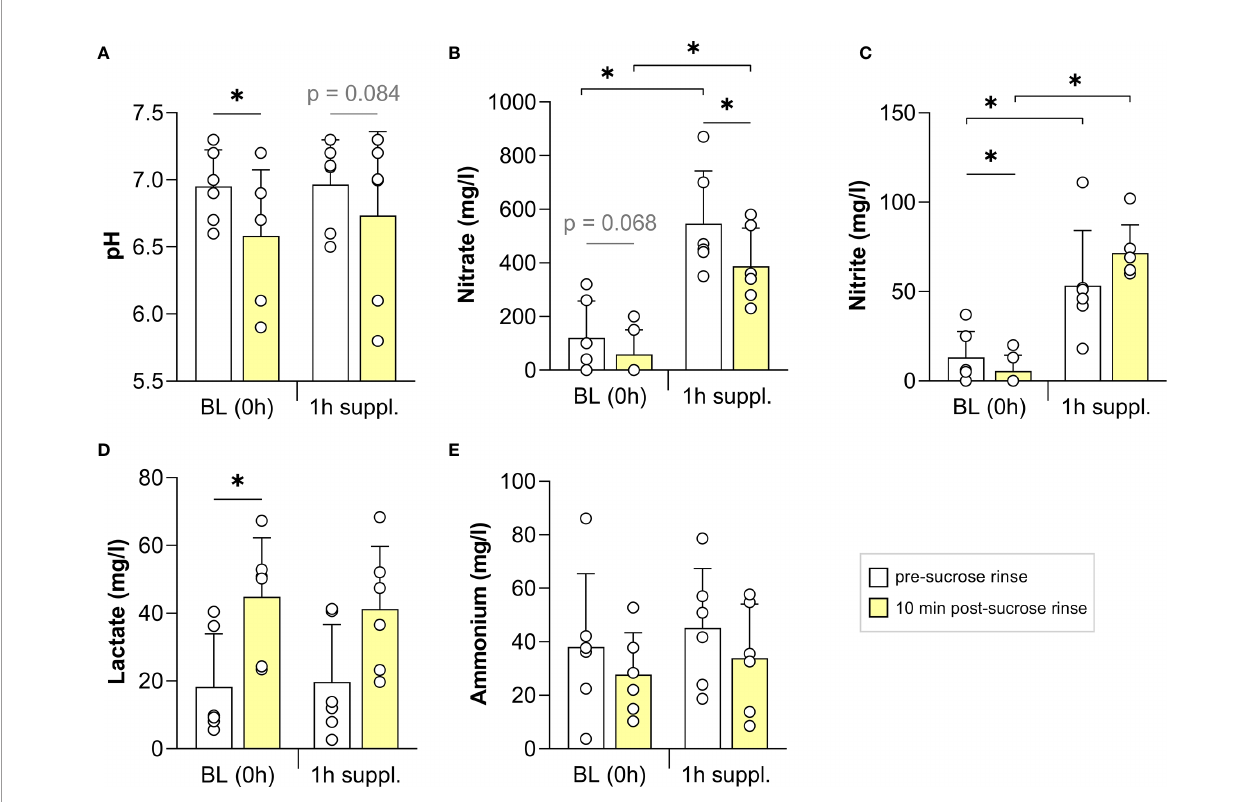
FIGURE 4 | The effect of a concentrated nitrate-rich supplement on sucrose rinses 1 h after intake. In six individuals, the salivary pH (A) and concentrations of nitrate (B) , nitrite (C) , lactate (D) and ammonium (E) were measured. Sugar rinses were performed at baseline (BL, 0 h) and 1 h after intake of a nitrate-rich supplement (300 mg nitrate in 70 ml). Saliva samples were collected immediately prior to the sugar rinse (pre-sucrose, white bars) and 10 min after the sugar rinse (post-sucrose, yellow bars). The bars and small white circles represent the averages and individual donor data, respectively. Wilcoxon tests were used to compare the pre-sucrose with the post-sucrose measurements. Additionally, the BL pre- and post-sucrose measurement were compared with 2 h pre- and post-sucrose measurements, respectively. Signi fi cant changes (*p < 0.05) and trends (grey text, p = 0.05 - 0.1) are